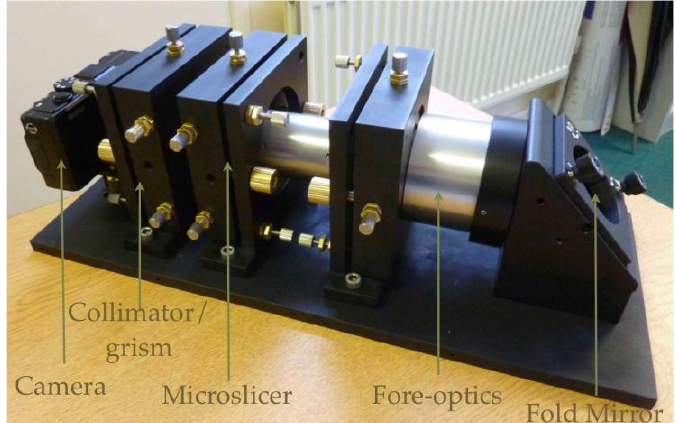
Figure 3. The prototype snapshot hyperspectral imager assembled in its field configuration with fold mirror. The cover is not